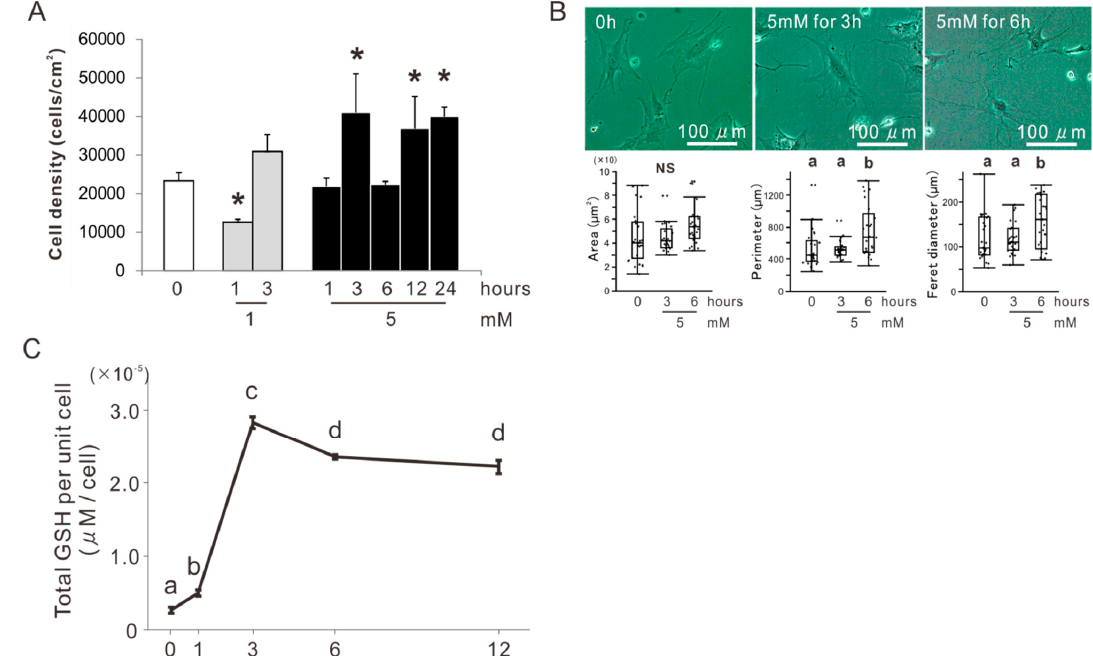
Figure 1. Determination of the concentration and incubation time of N -acetyl- L -cysteine (NAC) preconditioning for osteoblast-like cells. ( A ) Attached cell density on day 1 culture of rat femur bone marrow-derived osteoblast-like cells preincubated with and without 1 or 5 mM NAC up to 24 h. ( B ) Phase microscopic images and cytomorphometry for area, perimeter, and Feret diameter on day 1 culture of cells preincubated with and without 5 mM NAC up to 6 h. ( C ) Total glutathione (GSH) per unit cell in cell suspension with co-incubation with 5 mM NAC for 0, 1, 3, 6, and 12 h. The data are expressed as the mean ± standard deviation in 1A and C ( n = 3) or the box plots overlaid with dot plots in 1B ( n = 25). Asterisks in 1A indicate statistically significant di ff erences between cultures co-incubated with 0 mM NAC versus 1 mM NAC for 1 h and 5 mM NAC for 3, 12, and 24 h ( p < 0.05, Dunnett’s test). Di ff erent characters in 1B and C indicate statistically significant di ff erences between them ( p < 0.05, Tukey’s HSD test). NS in 1B indicates no statistically significant di ff erences between cultures co-incubated with 5 mM NAC for 0, 3, and 6 h ( p > 0.05, Tukey’s HSD